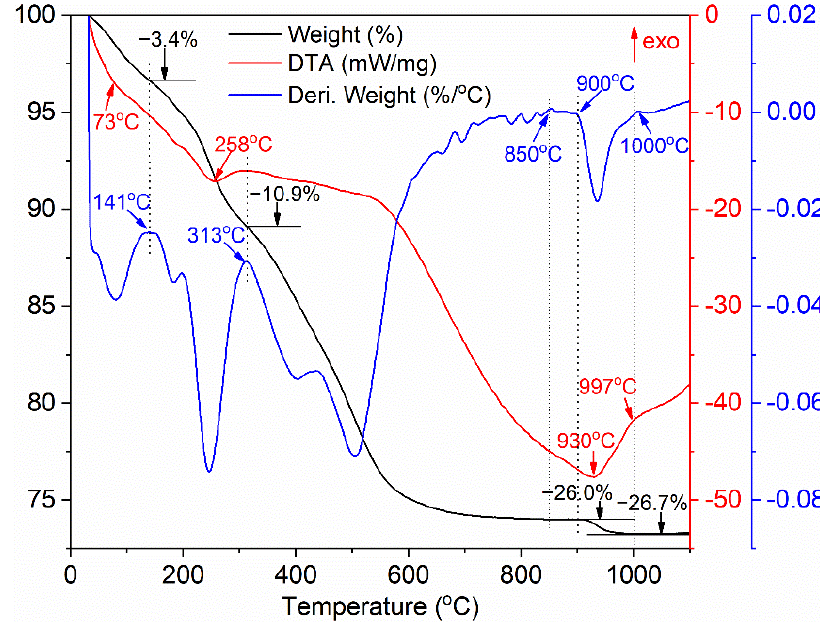
Figure 1. TG-DTA-DTG curves of the synthesized